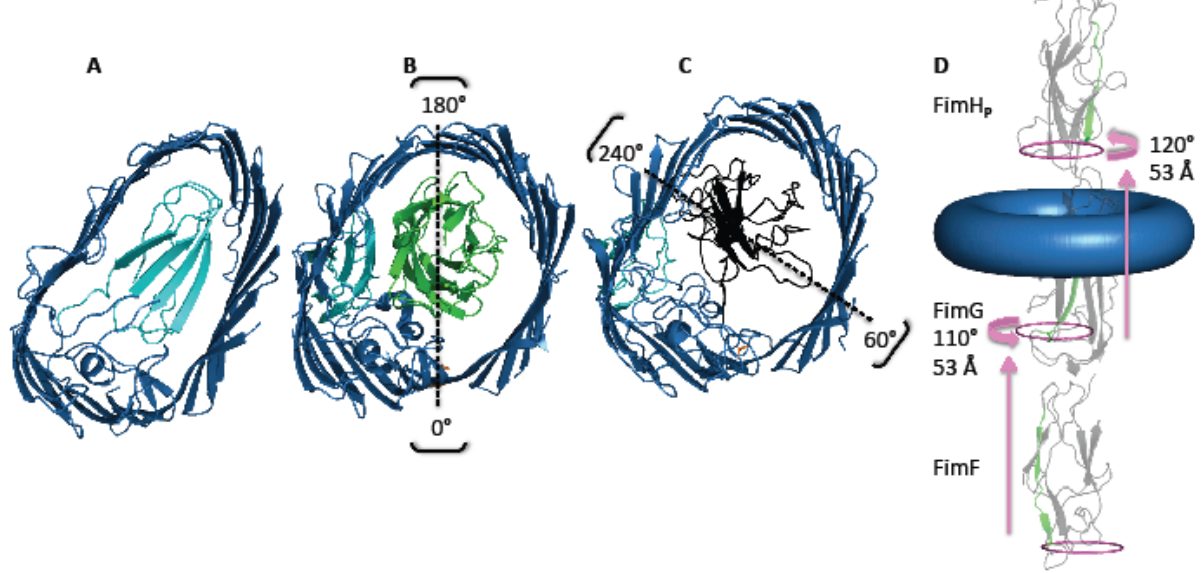
Figure 3. Shape and contacts of the FimD usher. (A) The pore (dark blue) displays an oval-shape and is filled by the plug domain (cyan) prior to secretion (PDB 3OHN). (B) Insertion of FimH (green) into the pore leads to removal of the plug and a change in pore shape to an inner circular tube (PDB 3RFZ) [25]. The strongest contacts between the pore and FimH are around 0 (cid:113) and 180 (cid:113) , taking FimD Asp208 (coloured in orange) as the 0 (cid:113) reference point. (C) In contrast, the strongest contacts when FimG (black) resides in the pore are around 60 (cid:113) and 240 (cid:113) (PDB 4J3O) [59]. (D) Subunits rotate by 110 (cid:177) 120 (cid:113) in an anticlockwise direction during translocation. Translation distances per subunit through the FimD pore is indicated by pink arrows. The start and end orientations for a homologous (cid:533) -strand from FimF, FimG and FimH p are shown in green (FimF A133-N123, FimG A113-T123, FimH